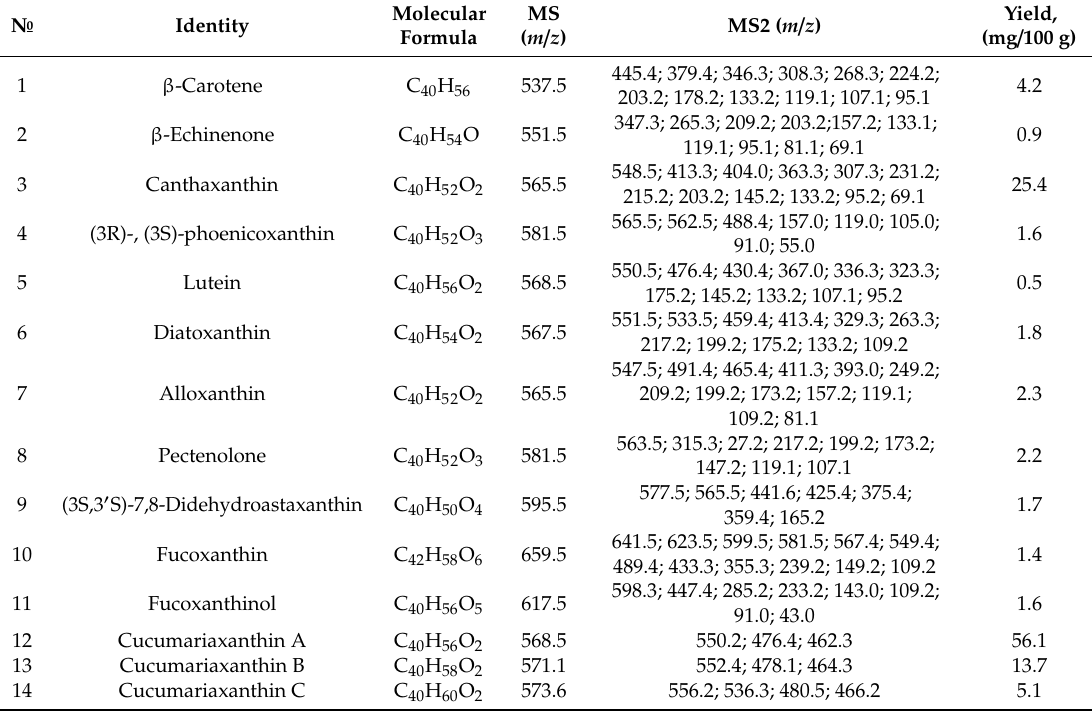
Table 2. Components identified from the supercritical extract of C. frondosa japonica Semper,